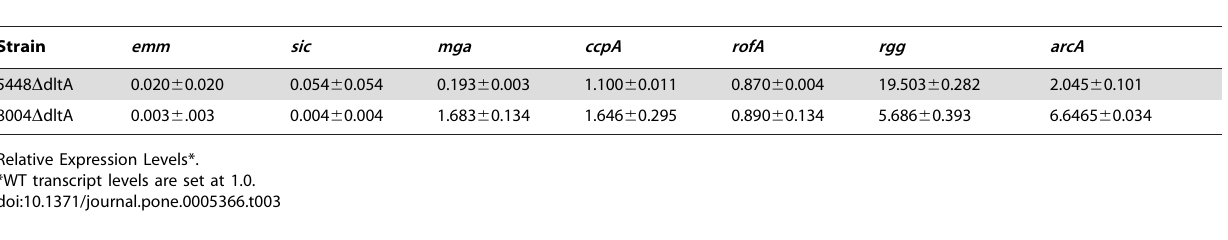
Table 3. Quantitative